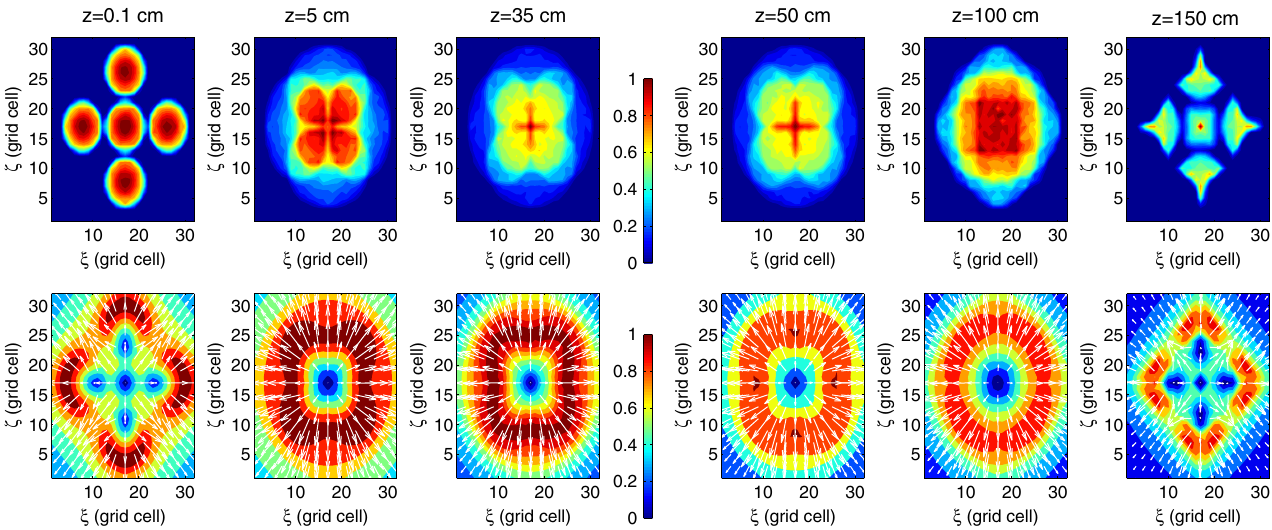
FIG. 13. (Color) z -integrated transverse distribution (top row) and corresponding charge-normalized transverse Lorentz force F ? [given by Eq. (3)] tabulated on a 32 (cid:10) 32 transverse grid (bottom rows). The color intensity represents the number of macroparticle (top row) and the force modulus (bottom row). The arrows in the bottom row give the Lorentz force directions (the arrow’s length is proportional to the force modulus). Each column corresponds to different position for the bunch center from the photocathode surface (as indicated on the top row) of z ¼ 0 : 1 , 5, 35, 50, 100, and 150 cm. The peak B-field of L3 is ^ B ¼ 0 : 376 T . The color coding convention for the density (respectively transverse force) is such that blue and red respectively correspond to lowest and largest electron population (respectively force modulus). Note that the plots are in units of the space-charge grid